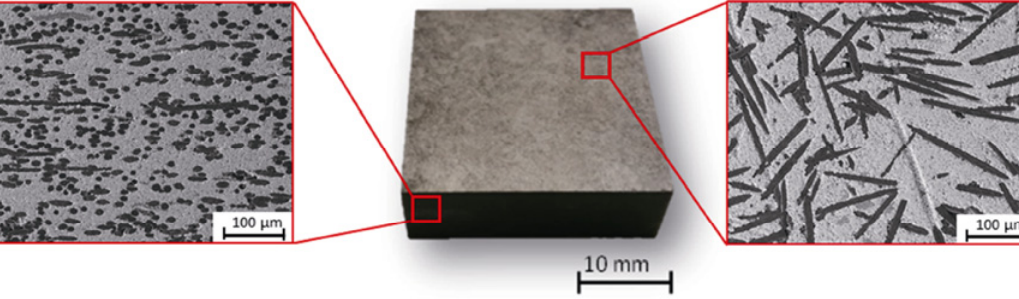
Fig. 4 Macro and micro images of Z5-35.